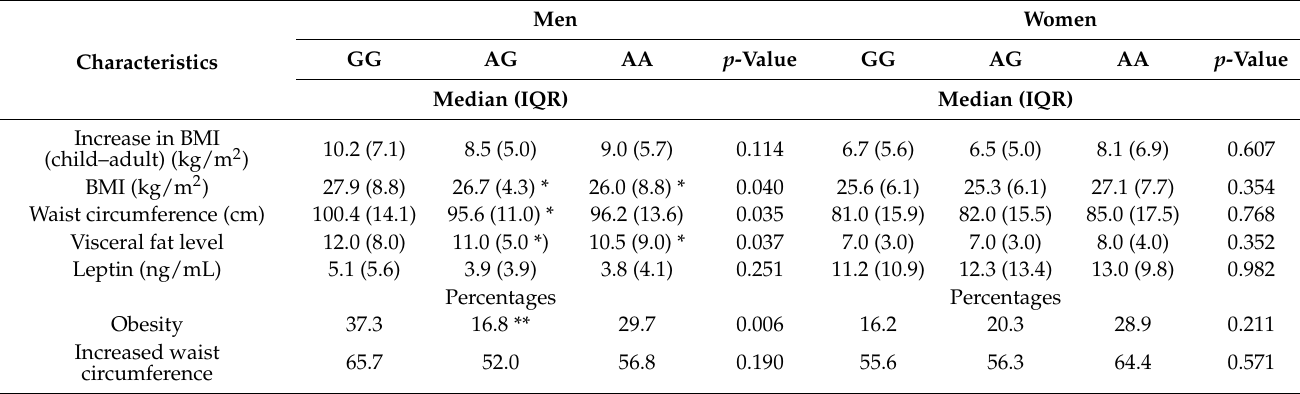
Table 7. Association of the LEP rs7799039 polymorphism with anthropometric measurements and leptin level in adulthood.